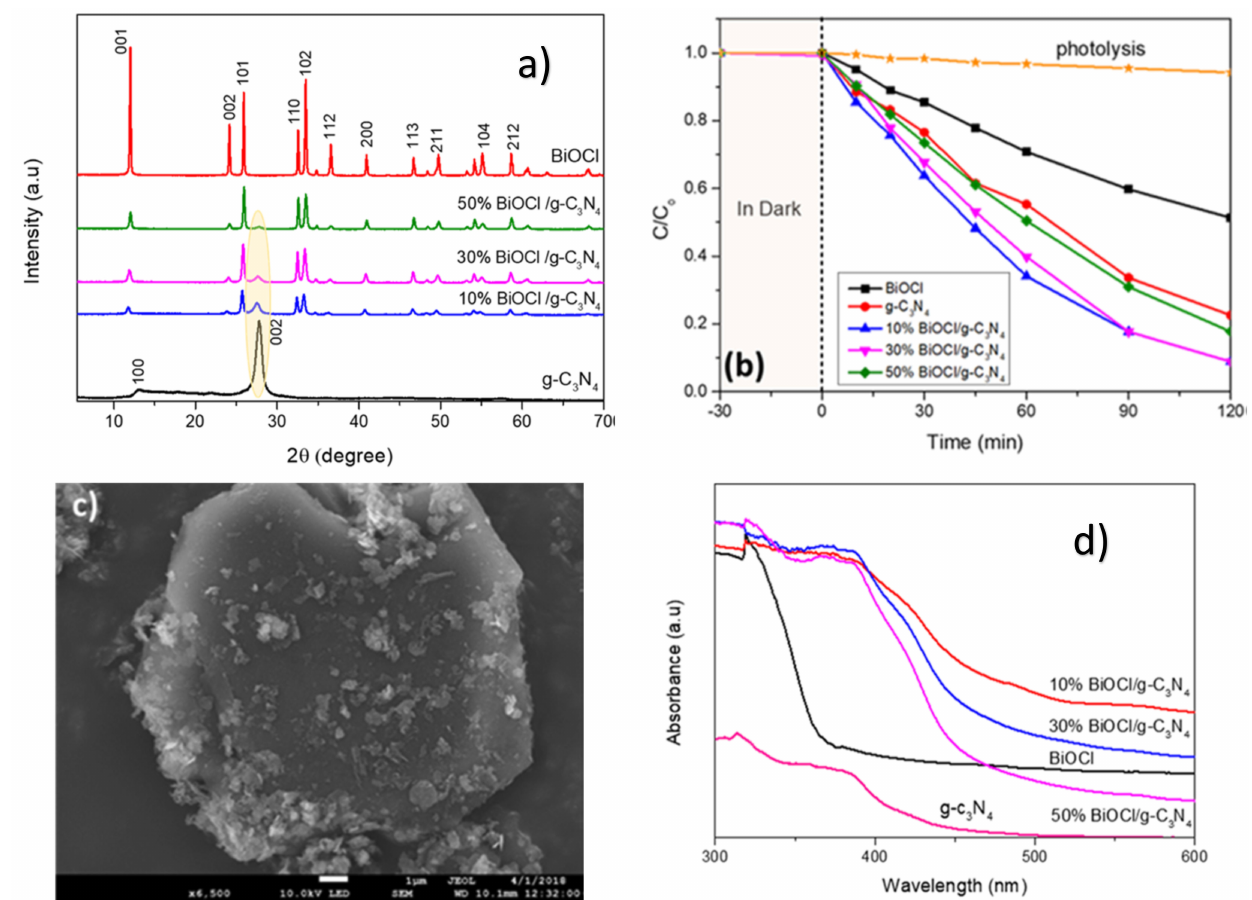
Figure 6. ( a ) XPR pattern of as-prepared BiOCl/g-C 3 N 4 samples; ( b ) Degradation rate of nizatidine at an initial concentration of 5 mg/L and pH = 5.6 with all the prepared samples; ( c ) SEM image of 10% BiOCl/g-C 3 N 4 sample; ( d ) UV-vis diffuse reflectance spectra of the obtained samples. Reproduced with permission from Al Marzouqi F et al, ACS Omega; published by American Chemical Society,